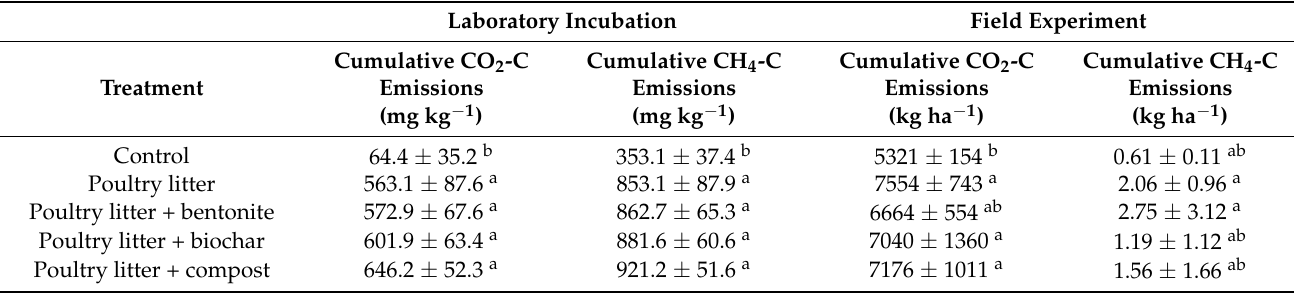
Table 4. Cumulative CO 2 -C and CH 4 -C fluxes (mean ± SD; n = 4) of the in vitro experiment in the laboratory (per kg dry soil-poultry litter blend), with cumulative field emissions shown for comparison. Statistical analyses: one-way ANOVA with Fisher’s LSD post-hoc test. Differences between treatments at p < 0.05 significance are marked by different